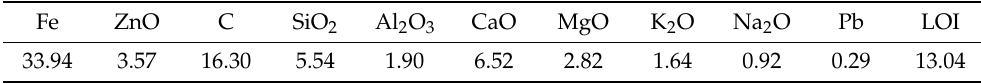
Table 1. Chemical composition of blast furnace sludge [wt.%] [5].